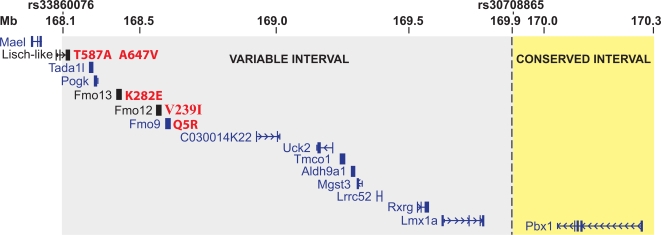
Genes in the Minimal Congenic Interval on Chr1:168.1–170.3 Mb.Gray background corresponds to the minimal DBA “variable” interval from 168.1 Mb–169.9 Mb, between markers rs33860076 and rs30708865. Yellow background corresponds to the centromeric end of the DBA vs. B6 “conserved” interval (i.e. nominally invariant). Genes in blue are from RefSeq; genes in black are predicted and locally confirmed as described in the text. The N-scan predicted gene chr1.1224.1 is designated here as “Lisch-like”. Amino acid variants are shown in red to the right of the corresponding gene. Nucleotide substitutions were confirmed by bidirectional sequencing in both C57BL/6J and DBA/2J DNA.